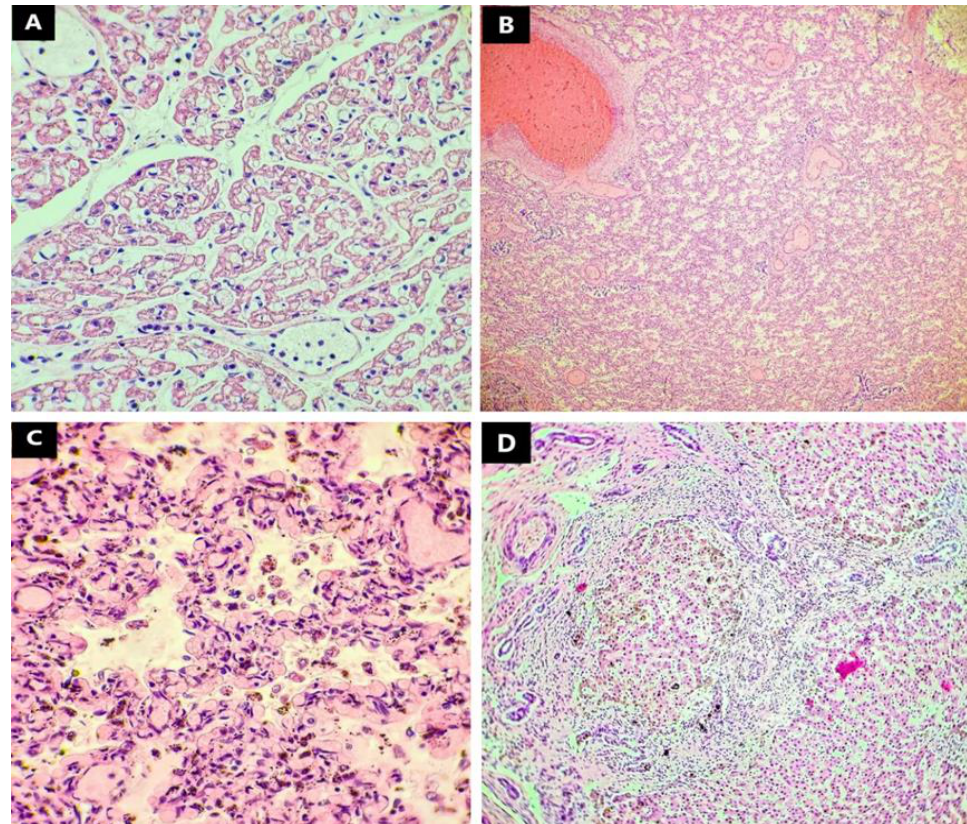
Figure 3. Microscopic aspect of the heart, lung, and liver — Haematoxylin Eosin (40× 100×): ( A ) (heart) (100×) large areas of myocytes expressing faintly granular expansion of the central clear zone with myofibrils showing exclusively at the periphery; ( B ) (lung) (40×), ( C ) (lung) (100×) lung parenchyma trapped in an early saccular phase with increased cellularity and prominent interstitium; ( D ) (liver) (100×) enlarged fibrotic portal tracts formed by dense collagen fibers — porto-portal bridging.